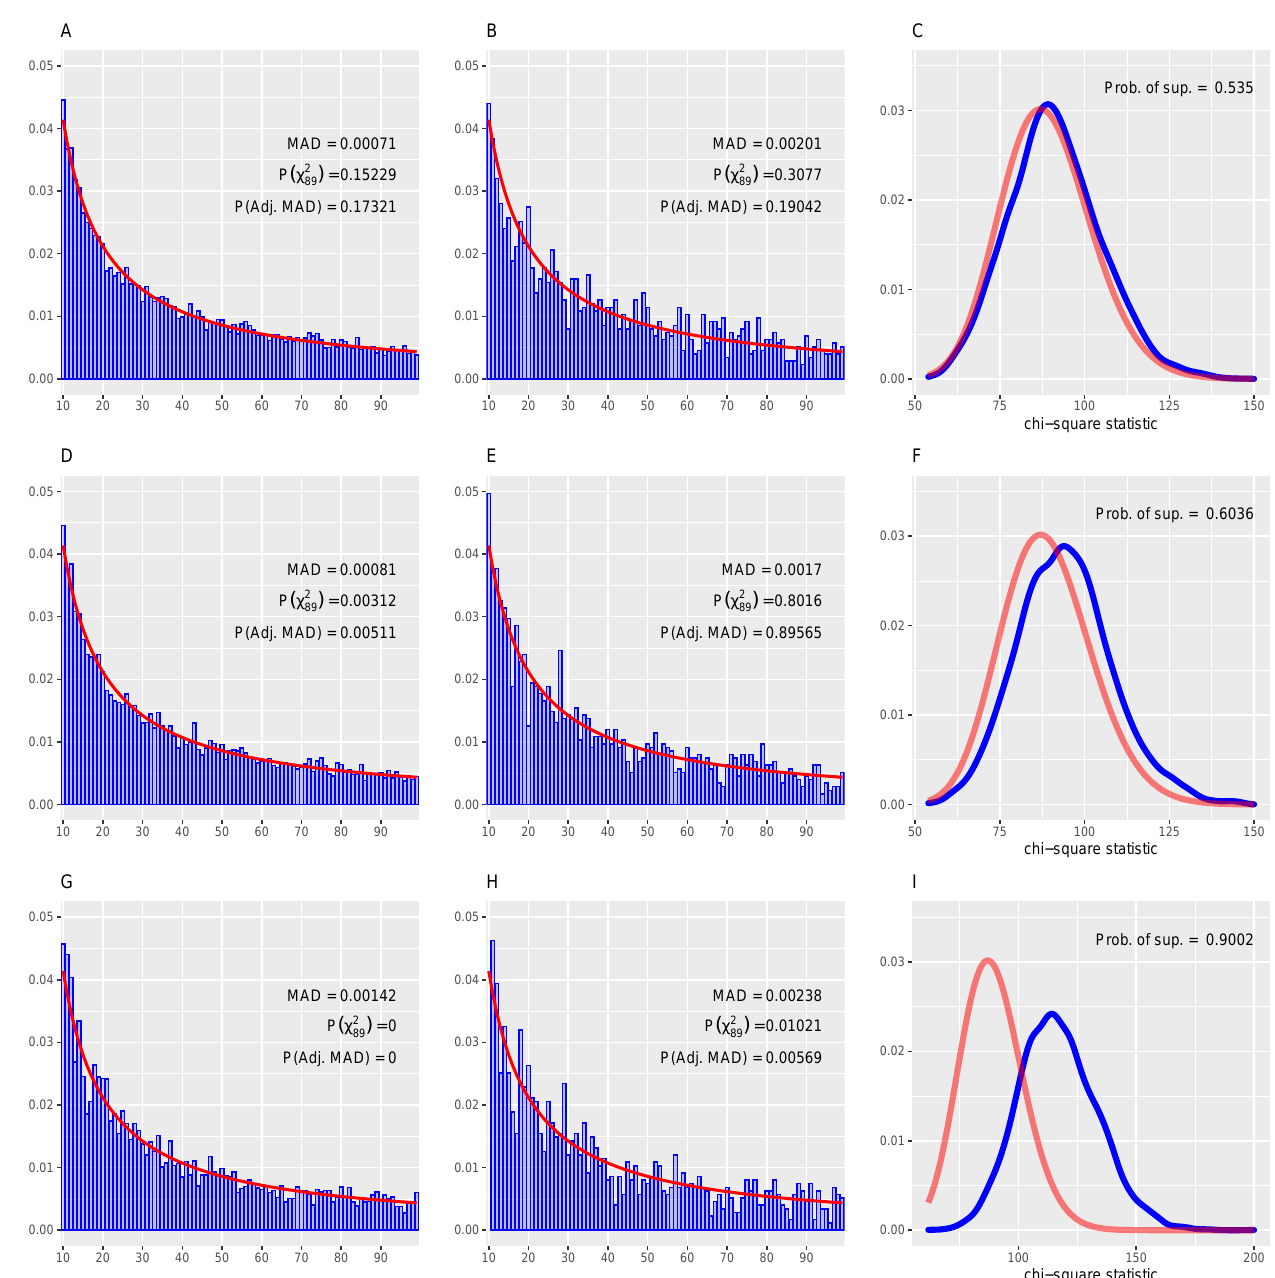
Figure 12. Behaviour of conformance tests across samples. In the first row (panels A – C ), data conform to the “first two digits” Benford’s law. In the second row (panels D – F ), data follow a perturbed Benford’s law with λ = 0.95. In the third row (panels G – I ), data are consistent with a perturbed Benford’s law with λ = 0.75. The first column (panels A , D , G ) reports the results computed over the full sample, with n = 15,000. The second column (panels B , E , H ) is relative to a single random subsample with n = 1750. The third column (panels C , F , I ) reports the estimated densities (blue) of the conventional (or Wald) chi-square test statistic over 5000 random subsamples of length n = 1750 along with the χ 2 ( 89 ) distribution under the ) and P ( Adj . MAD ) denote p values of the conventional (or Wald) chi-square test and of the null distribution (red). P ( χ 2 89 adjusted MAD test, respectively. Prob . of sup . is an estimate of the probability of